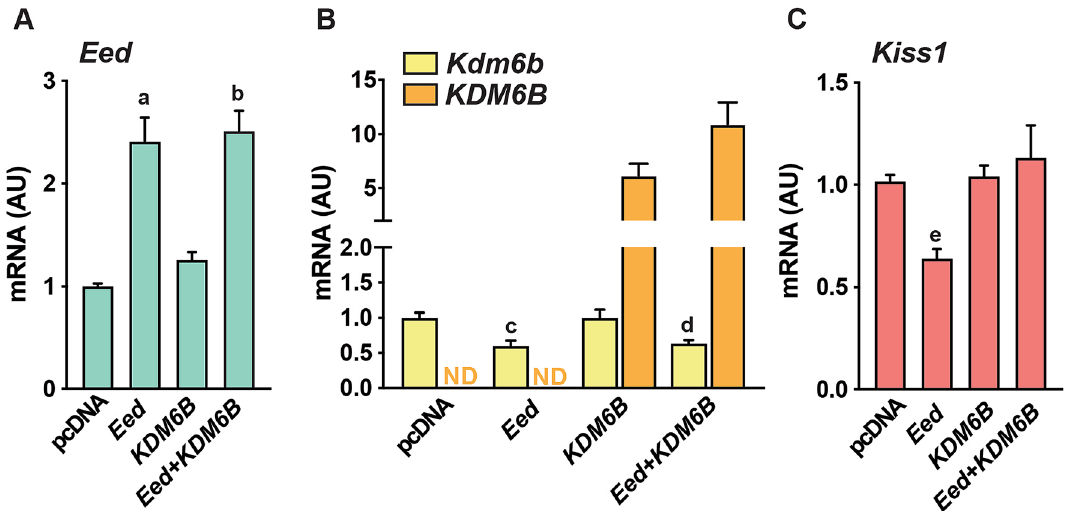
Figure 6. KDM6B counteracts the effects of EED. Rat R22 cells were transiently transfected with rat Eed , a human KDM6B expression vector or both. Expression of ( A ) rat Eed , ( B ) rat endogenous Kdm6b (yellow bars) and human exogenous KDM6B (orange bars) and, ( C ) rat Kiss1 was determined 48 h after transfection. mRNA levels were measured by qPCR. Results are expressed as fold change with respect to control-pcDNA values. a,b p < 0.001 vs pcDNA and KDM6B groups. c, d, p < 0.05 vs pcDNA and KDM6B groups. e, p < 0.05 all other groups (One Way ANOVA followed by Student-Newman–Keuls test) (n = 3 per group). N.D. = not